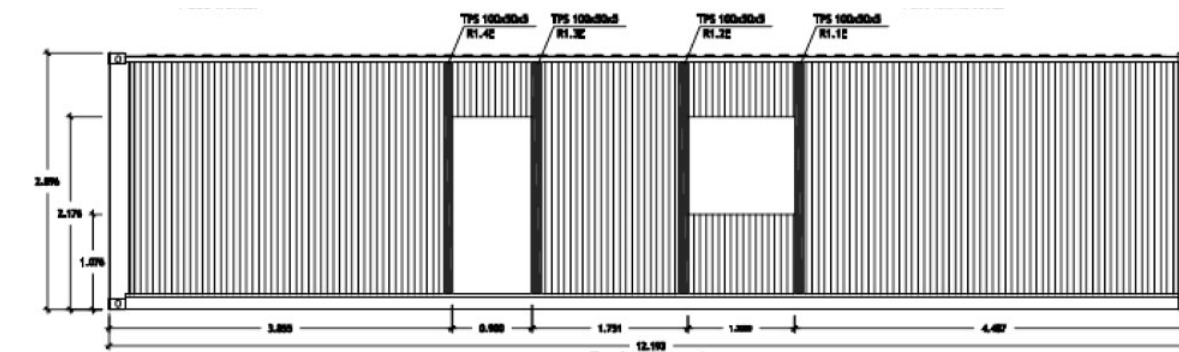
Fig. 15. Preparation of the container 1-40’HC.1